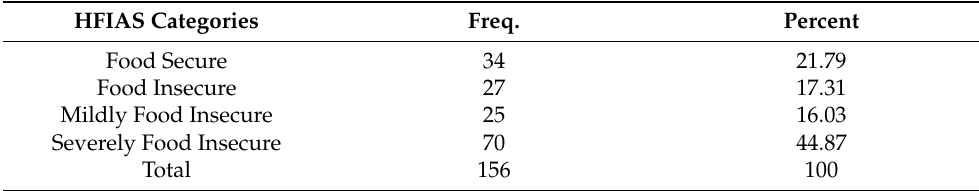
Table 5. Prevalence of university students’ food insecurity status.